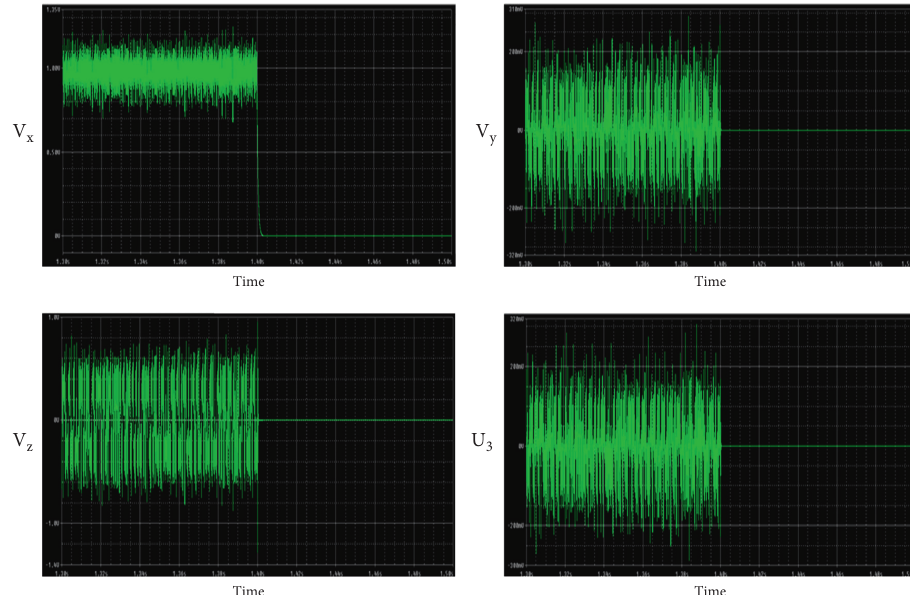
Figure 11: Time series of chaos suppression in SynRM without external inputs generated from the Pspice oscilloscope for the capacitors and resistors: C � 3 . 33 k Ω R 6